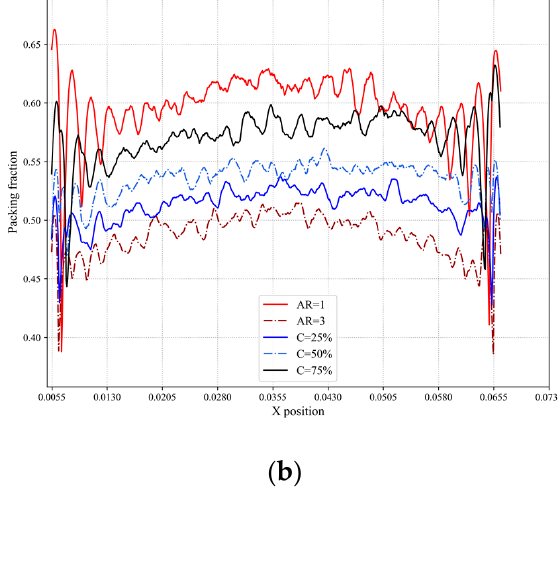
( f ) Figure 7. Packing fraction along x,y,z direction for ( a , c , e ) binary mixtures of AR = 1 and AR = 2, monodisperse AR = 1 and monodisperse AR = 2, and ( b , d , f ) binary mixtures of AR = 1 and AR = 3, monodisperse AR = 1 and monodisperse AR = 3. 3.3. Local Packing Structure Analysis The cumulative distribution functions (CDFs) of the local packing fraction are shown in Figure 8. The local packing fractions were calculated using the results of Voronoi tes-